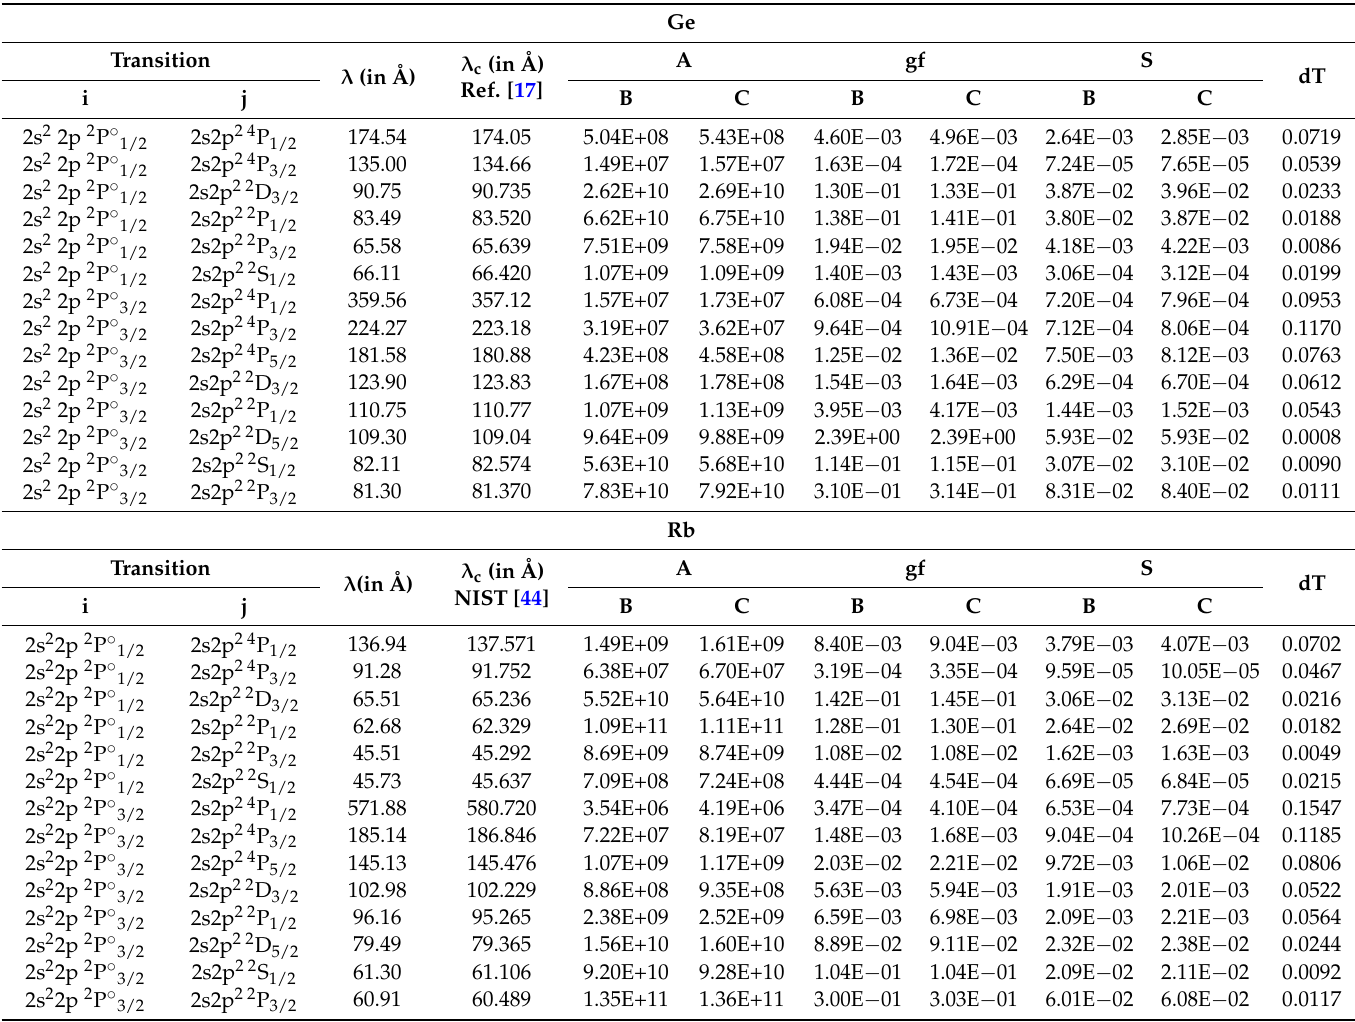
Table 4. Transition data for E1 transitions for B-like ions from 2s 2 2p 2 P ˝ 1/2, 3/2 : lower level i, upper level j, wavelength λ (in Å), transition rate A (s ´ 1 ), weighted oscillator strength gf, line strength S (in a.u), and accuracy indicator